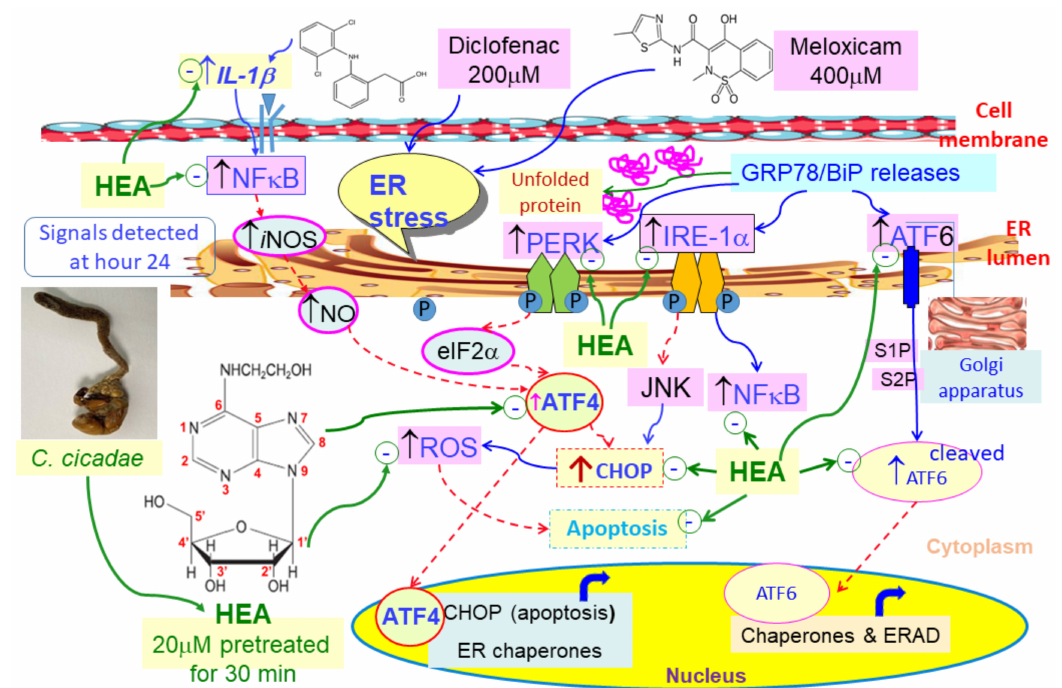
Figure 8. HEA alleviated the nonsteroidal anti-inflammatory drugs (NSAIDs) DCF- and MXC-induced ER stress via the GRP78/ATF6/PERK/ IRE1 α /CHOP pathway. The ER homeostasis was disturbed by NSAIDs, which triggered the dissociation of transcription factor 6 (ATF6), protein kinase R-like ER kinase (PERK), and inositol-requiring enzyme 1 α (IRE1 α ) from GRP78/binding protein (BIP). HEA effectively prevented ER stress by attenuating ROS production and gene expression of ATF–6, PERK, IRE1 α and CHOP. Solid blue arrows → : signals induced by applied NSAIDs. Solid green arrows → : attenuation by HEA, N 6 -(2-hydroxyethyl)adenosine. Dotted red arrows - - - → : literature-cited